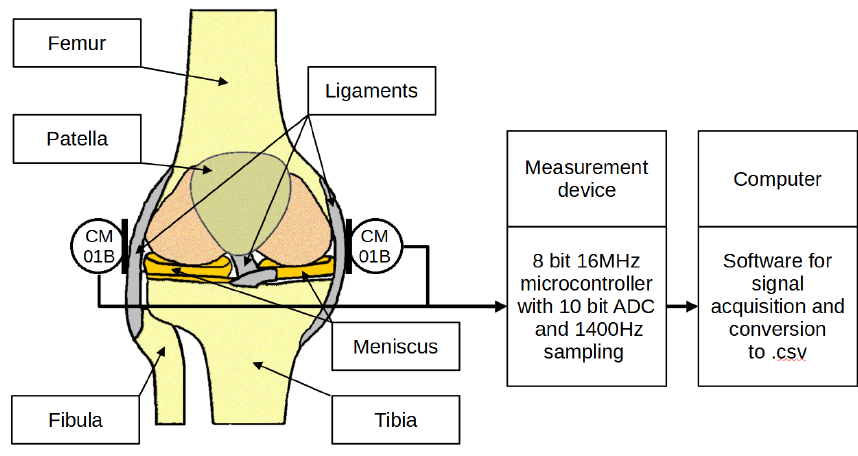
Figure 3. Sensor placement on the knee area and general measurement concept.